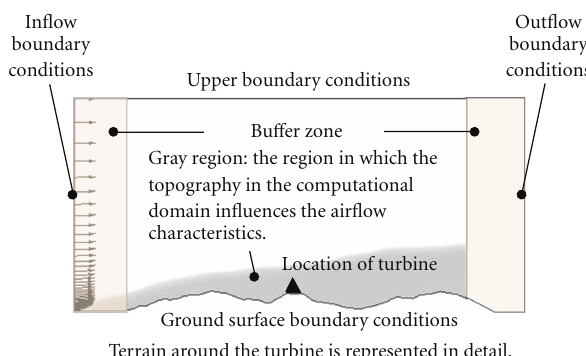
Figure 1: Computational domain and boundary